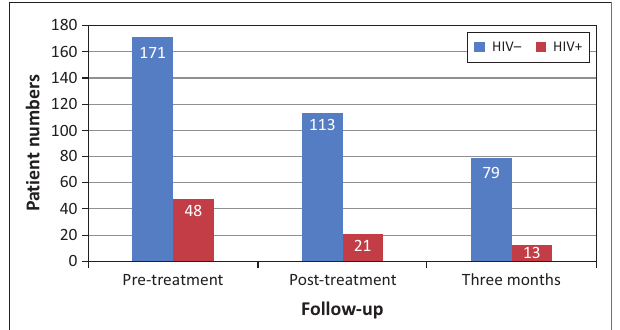
FIGURE 1: Follow-up of HIV-negative versus HIV-positive women over the study